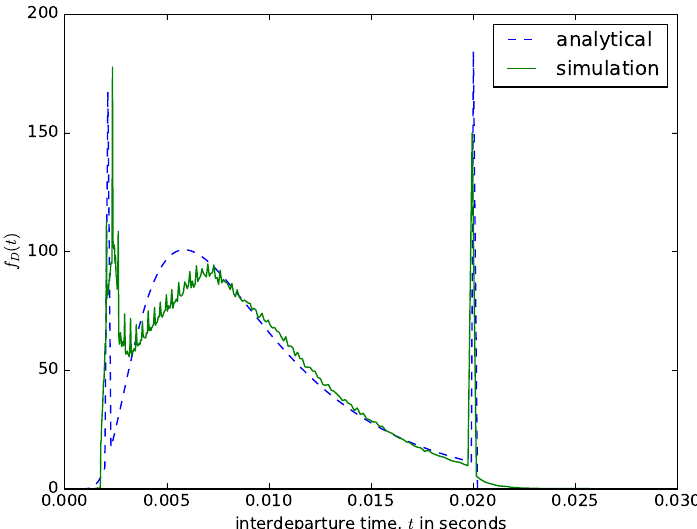
Figure 12. The distribution of the interdeparture times for a hybrid packet aggregation